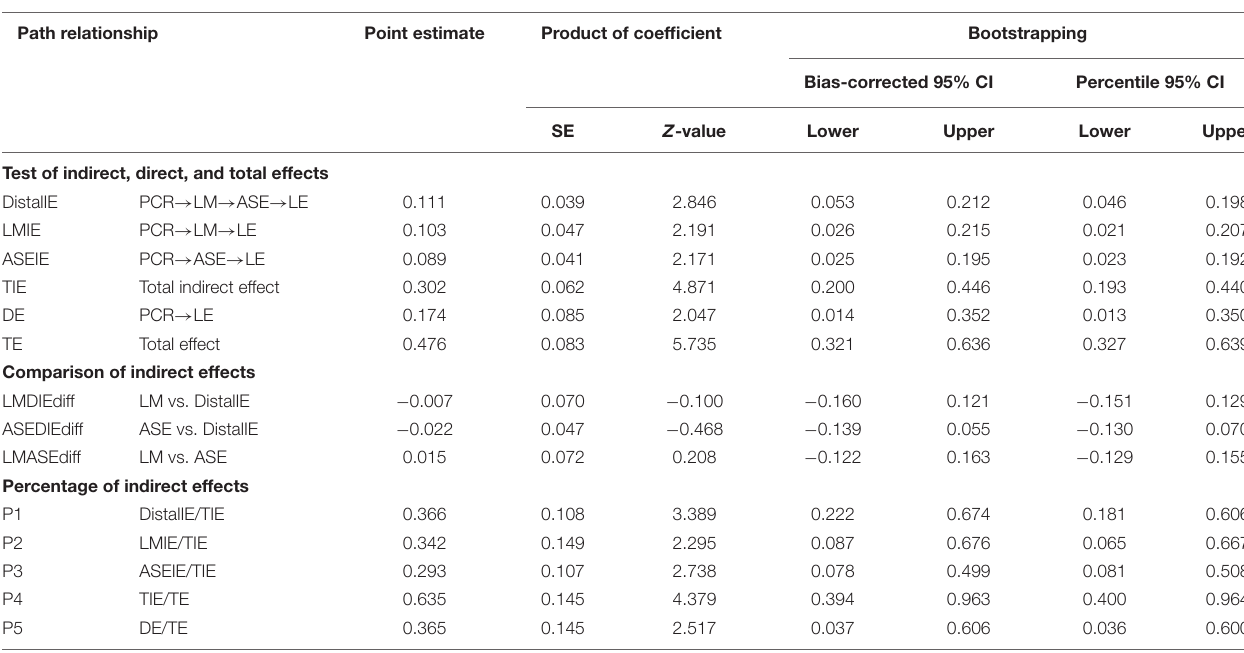
TABLE 6 | Direct, indirect, and total effects of the hypothesized